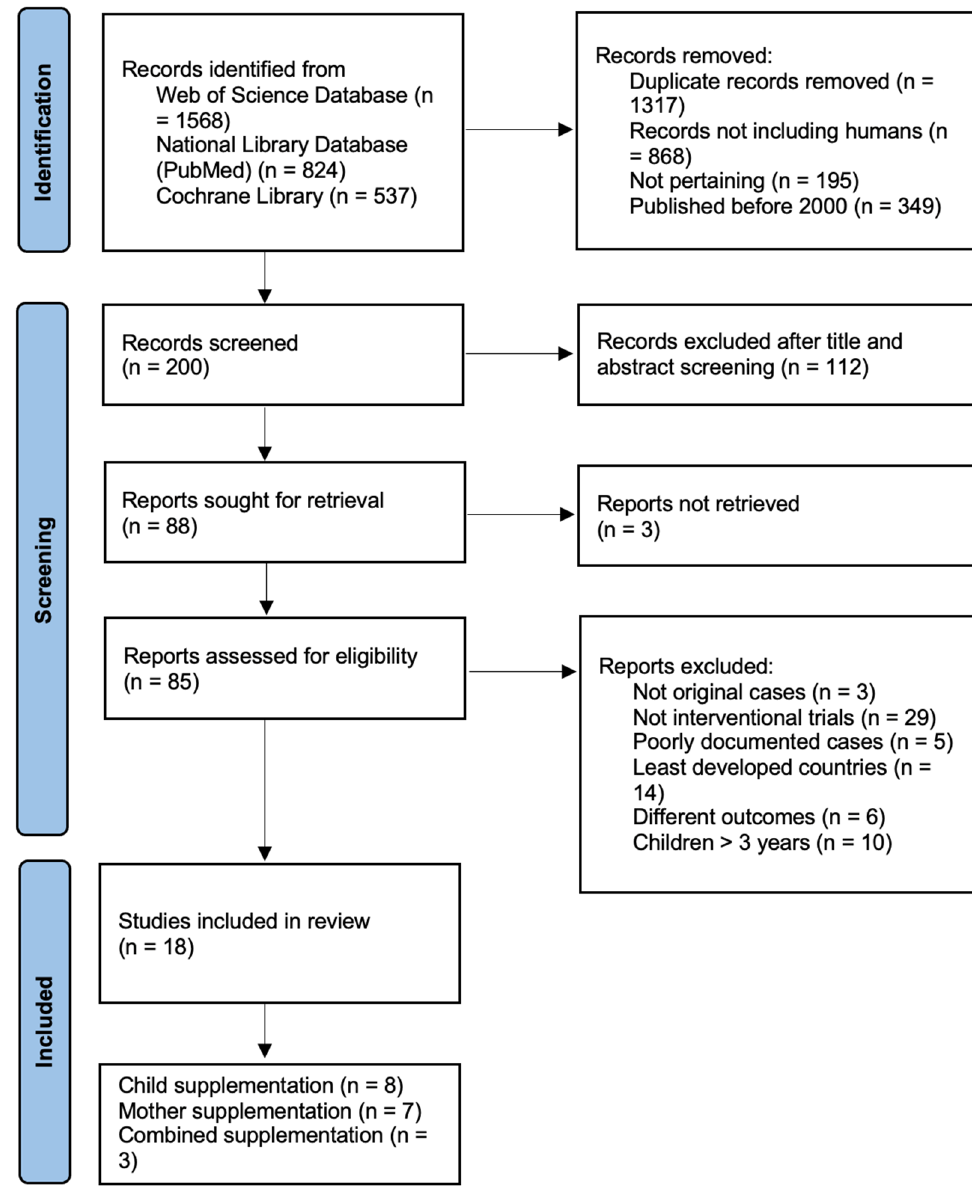
Figure 1. PRISMA flow diagram for systematic reviews.